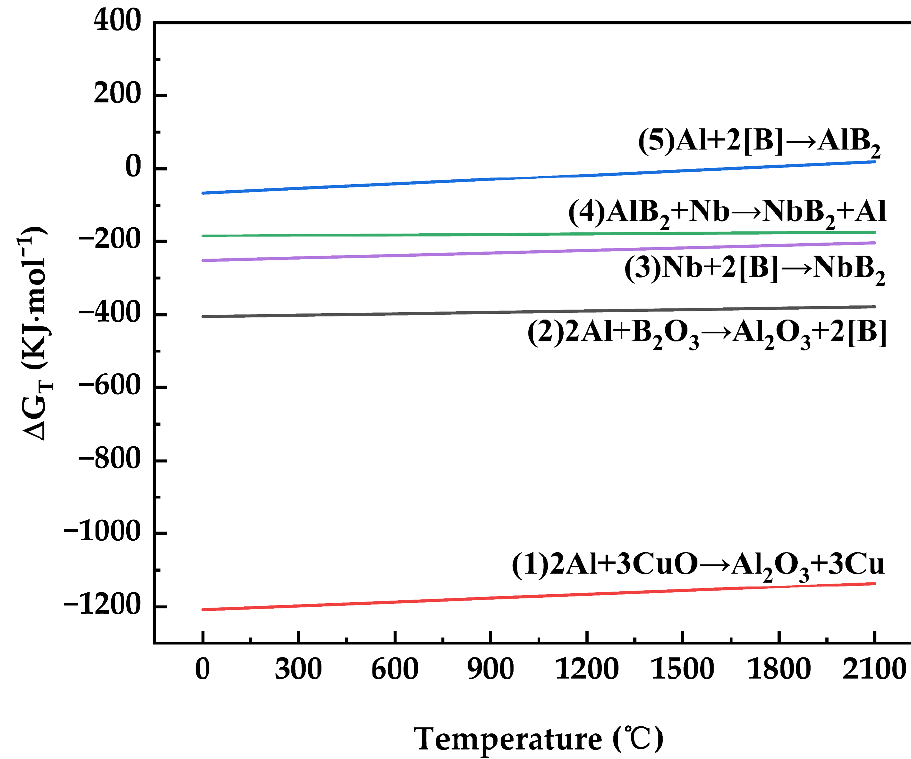
Figure 3. Gibbs free energy versus temperature for reactions (1)–(5).